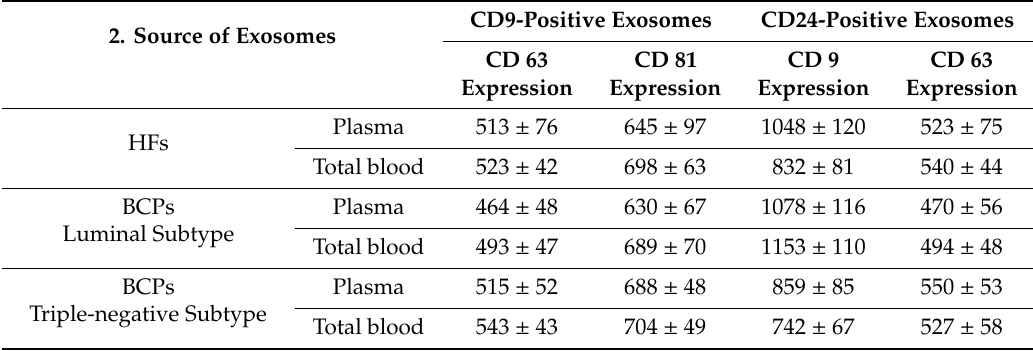
Table 3. Expression of CD 24, CD 63 and CD 81 on the Surface of Exosomes from Plasma and Total Blood of HFs and